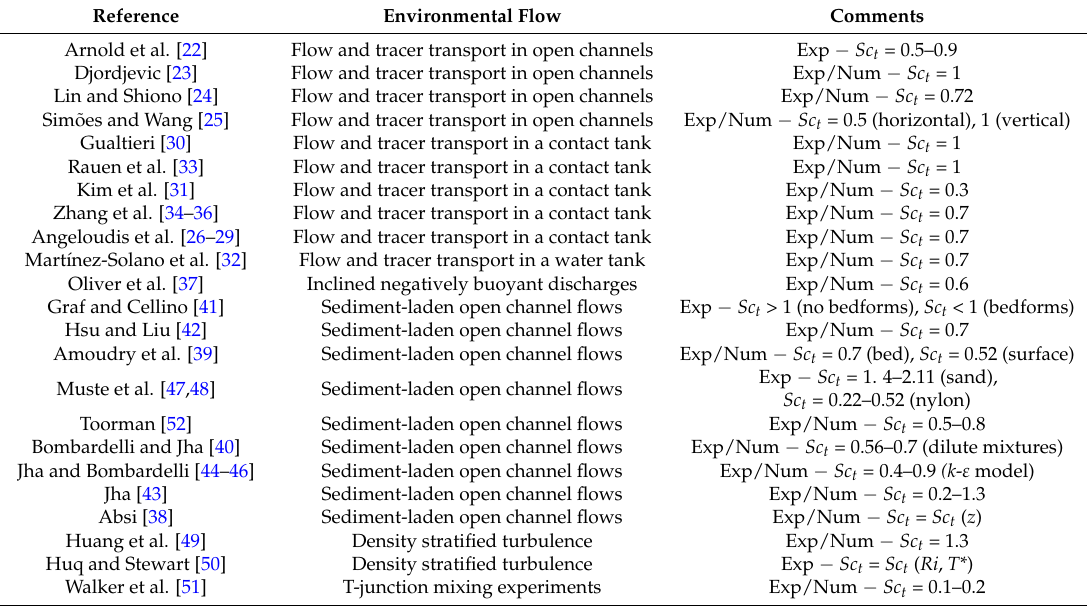
Table 2. Values of the turbulent Schmidt number from water systems literature. Exp, experimental; Num,